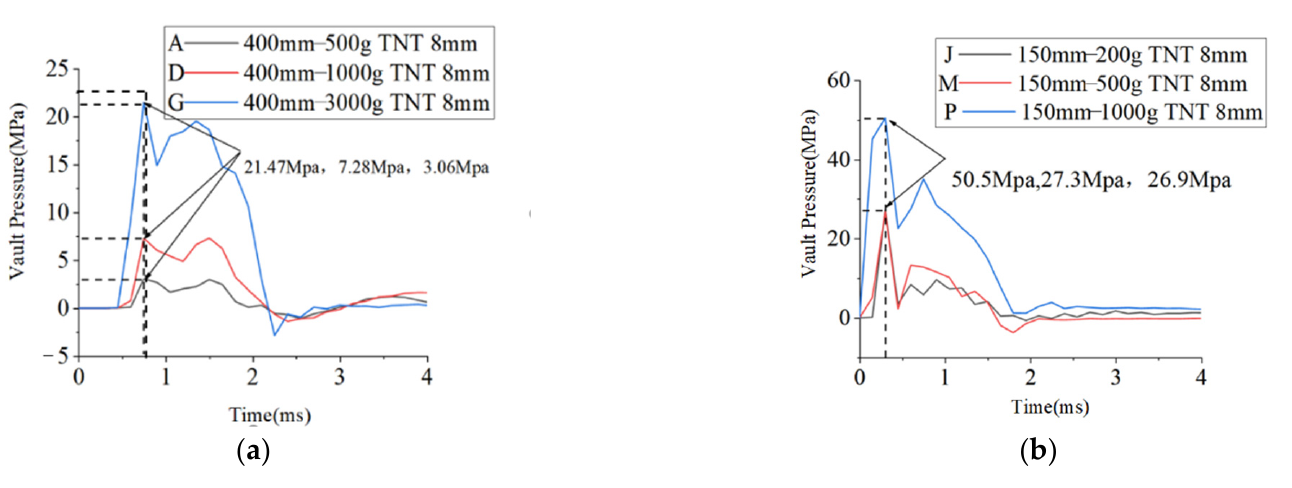
Figure 10. Dynamic pressure at arch vault under the conditions of ( a ) A, D, and G, and ( b ) J, M, and P. By replacing the values of various parameters in Equation (1) with the SI units, the calculation formula of the peak value (MPa) of the free field pressure in the soil can be obtained: Using the scaled distance of each group to calculate P 1 , the pressure on the vault of each group was recorded and the Table 9 was obtained. Table 9. Pressure on the arch